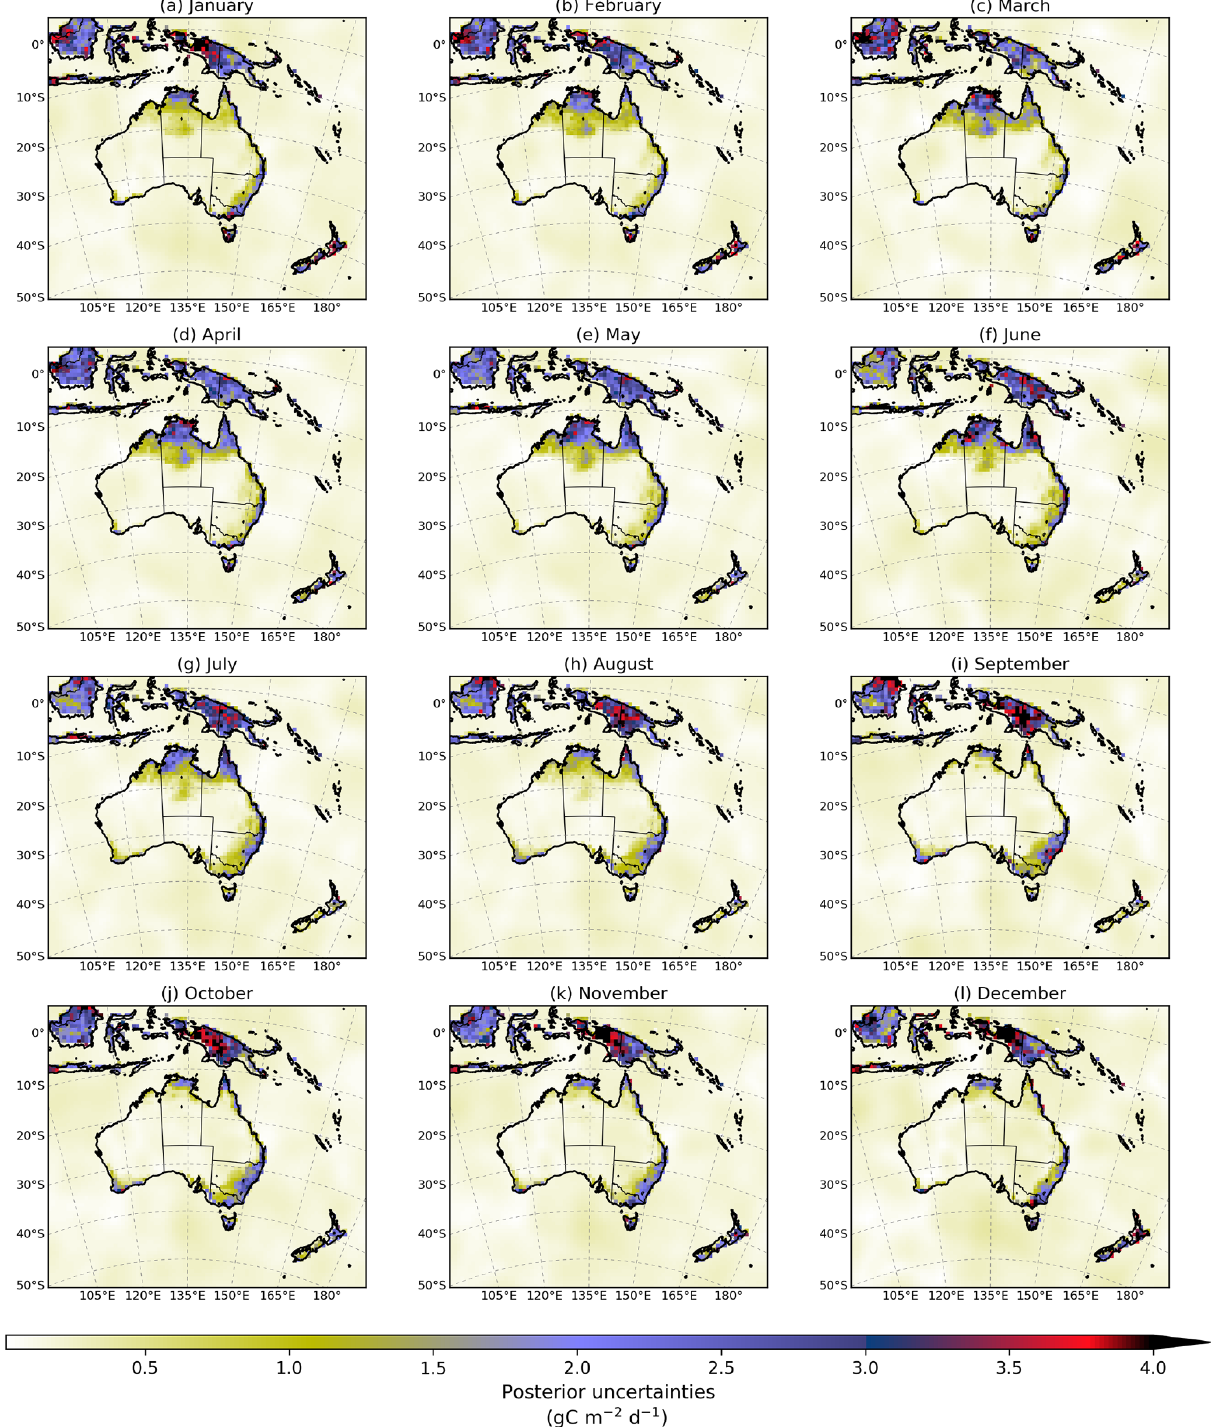
Figure D1. Prior uncertainties accounting for the major terms in the CO 2 budget (anthropogenic fluxes, fires, land and ocean exchange).